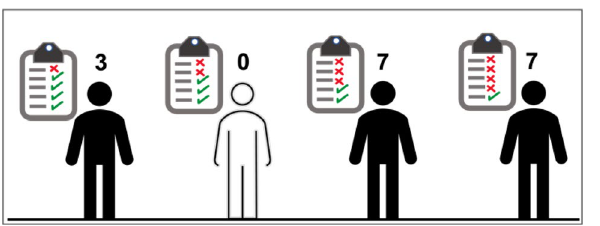
Figure 5. The spectral changes for five urine components (urea, citrate, creatinine, phosphate groups, and uric acid) are counted for each participant. Seven individuals showed a change in three of their urine components and another seven showed a change in their four different urine